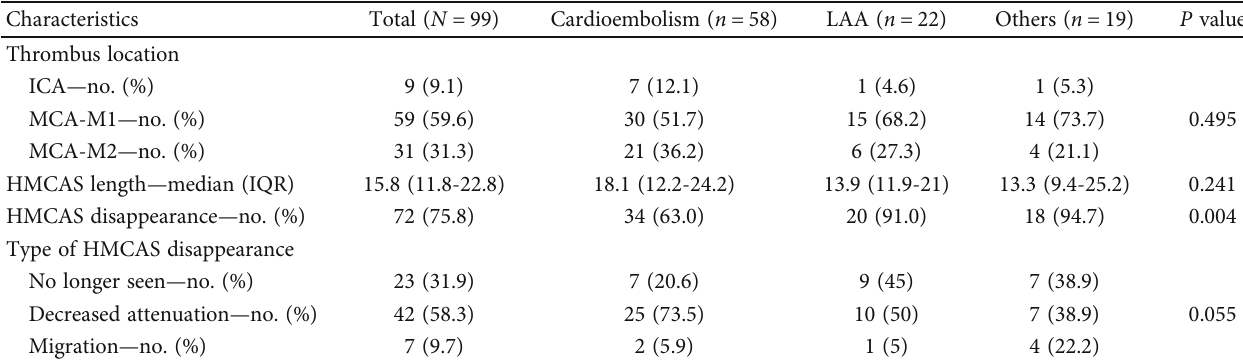
Table 3: Characteristics of HMCAS in di ff erent stroke subtypes.